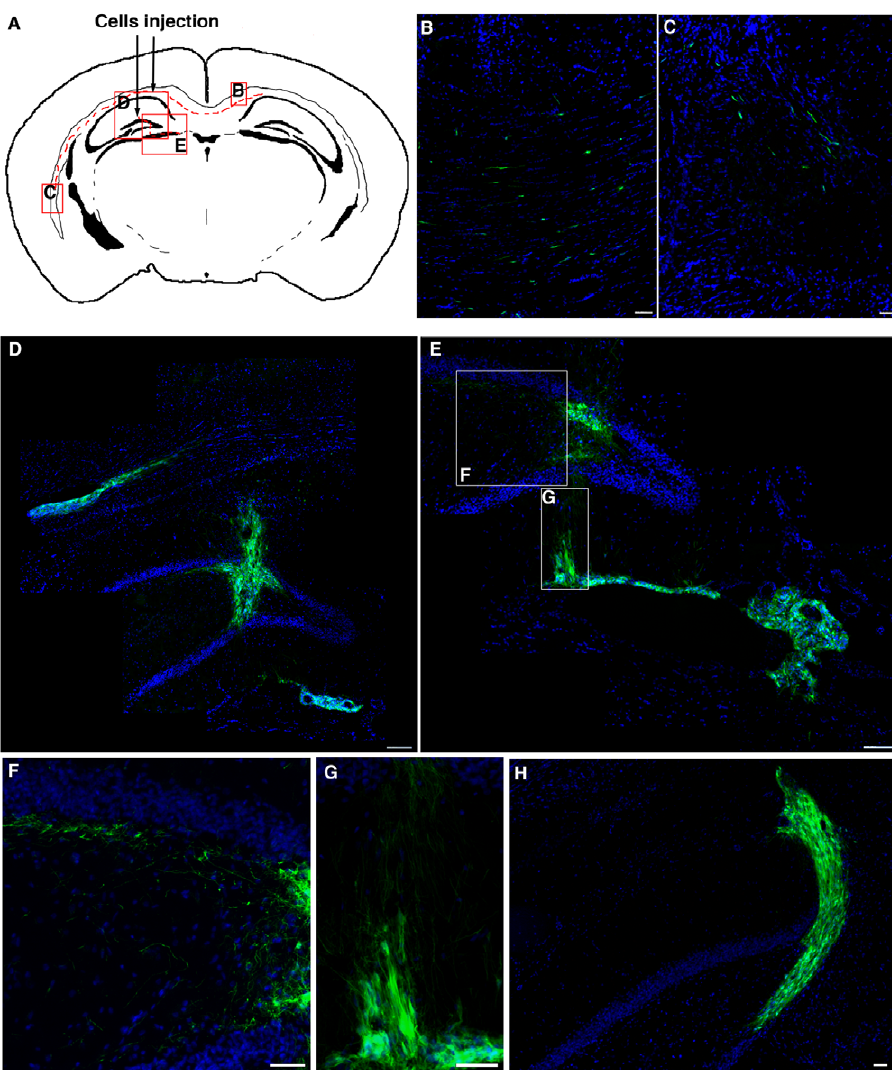
Figure 4. Long-term survival of IhNSC-Ps after transient immunosuppression. (A) Map of the brain areas colonized by IhNSC-Ps in transiently immunosuppressed ischemic rats 4 months following transplantation. Letters in boxed area refer to the figures B–E. IhNSC-Ps migrate extensively through the cc (B–C) and along the dentate gyrus (D, E and H) to the underling SVZ (D, E). F and G magnifications of boxed areas in E. Scale bars: B,C,E,F,G and H: 50 m m; D: 100 m m.